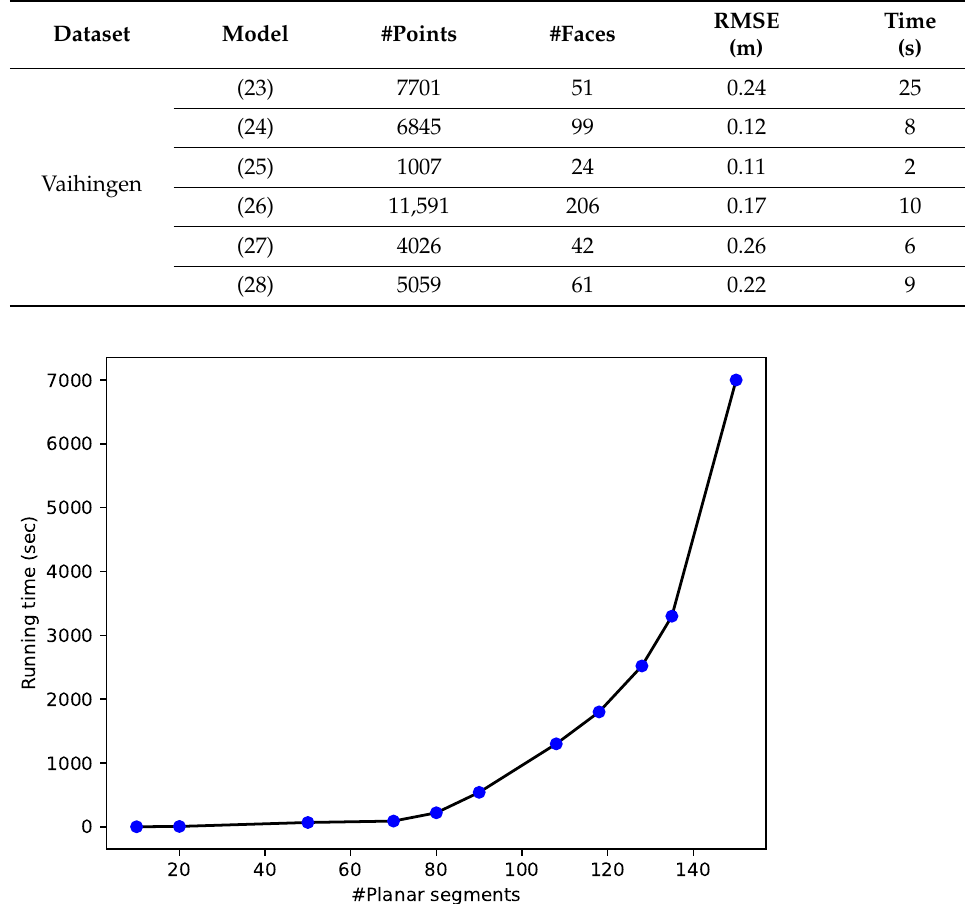
Figure 7. The running time of our method with respect to the number of the detected planar segments. These statistics are obtained by testing on the AHN3